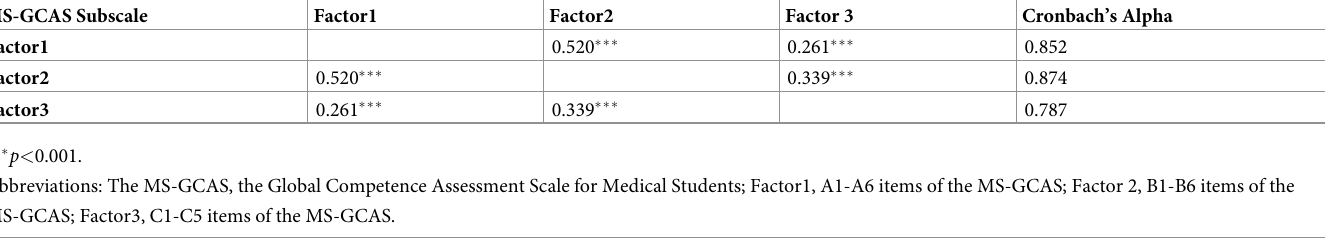
The one-way ANOVA analysis of the MS-GCAS score of the different groups is shown in Table S2 in S1 File. In the multivariate regression analyses (Table 4), the students in the clinical clerkship have significantly higher scores of factor 3 than those in the premedical courses (OR = 1.116, 95% CI: 1.037–1.201, p = 0.004). The students with the bottom third of the grade level have lower scores of factor 1 than those with the top one-third of the grade level